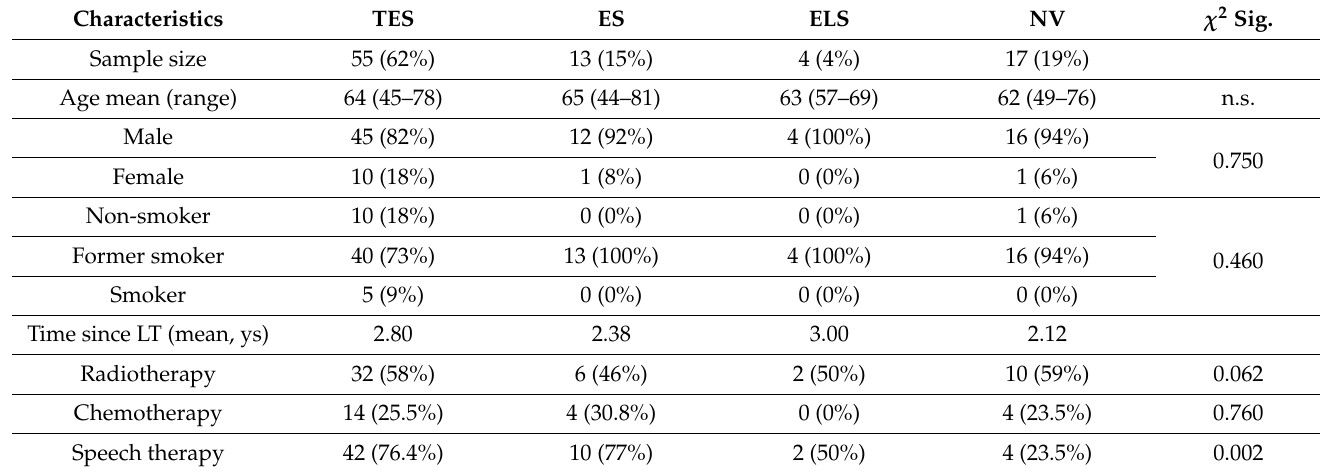
Table 1. Clinical and sociodemographic